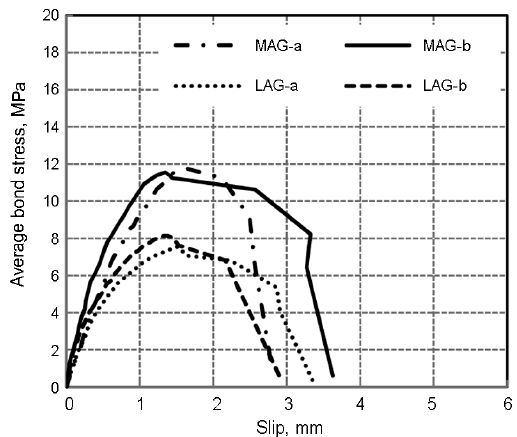
DFig. 8. Average bond stress-slip curves in specimens with GFRP bars bonded with epoxy A